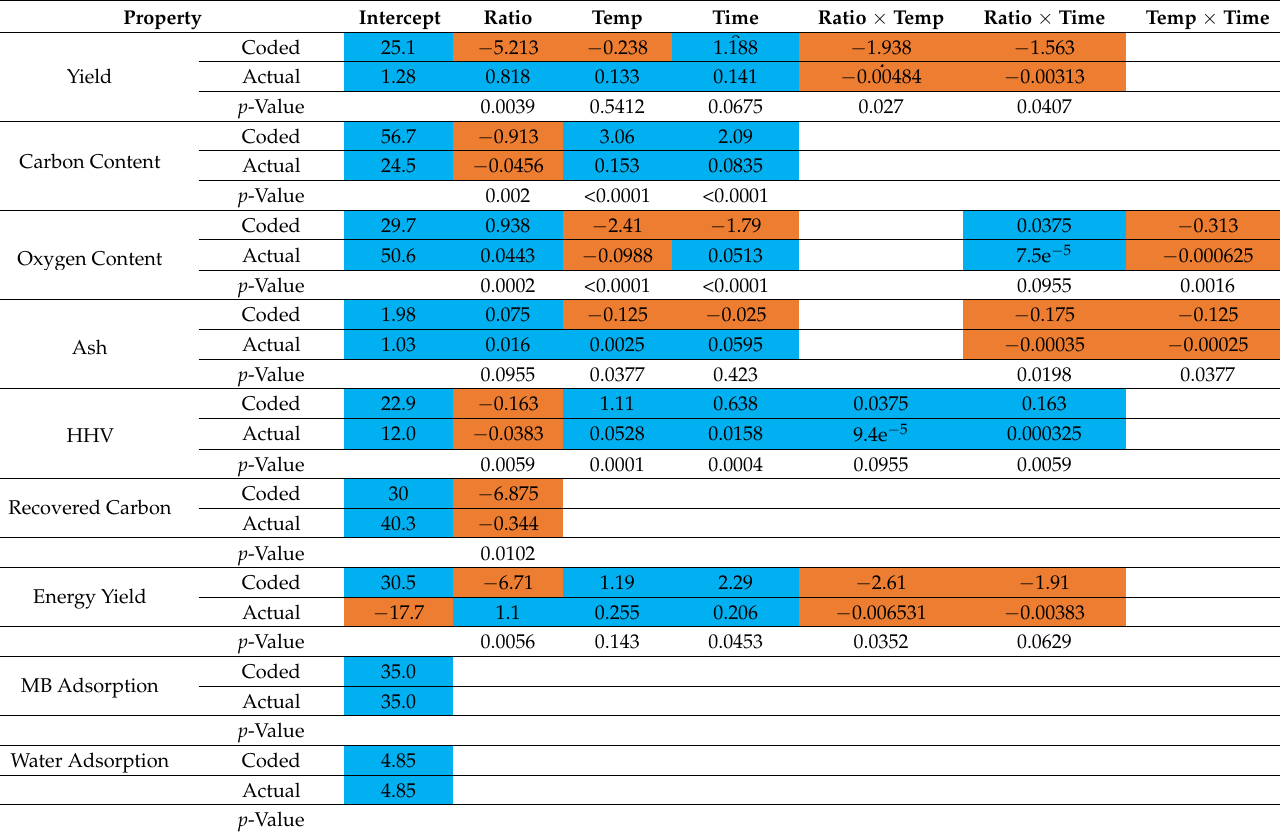
Table A5. Coded and actual equation for each HC property, with colour